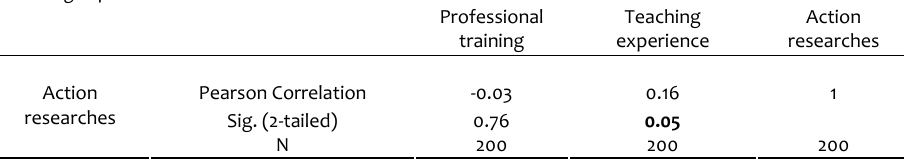
Table 5 : Correlation between conducting action researches and teachers’ professional training and their teaching